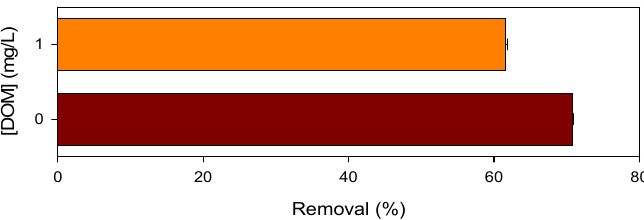
Figure 8. Influence of DOM on CBZ degradation by the Mn(III)/HSO 3 − process. [CBZ] 0 = 5 µM, [Mn(III)] 0 = 50 µM, [HSO 3 − ] 0 = 250 µM, [PP] = 2.5 mM, pH = 7.0.